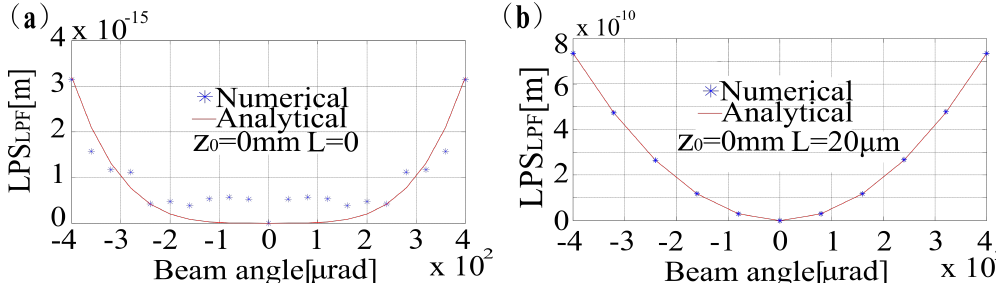
Figure 2. ( a ) When the waist position of the Gaussian beam coincides with the rotation point of the flat-top beam and the detector is an large enough plane with no gap, LPS LPF is shown to be significantly below the picometer scale. (the differences are numerical errors related to the ray tracing algorithm). ( b ) When the gap size of detector is 20 µ m, the balance of ( a ) is disturbed and LPS LPF is shown to be increased to 10 pm